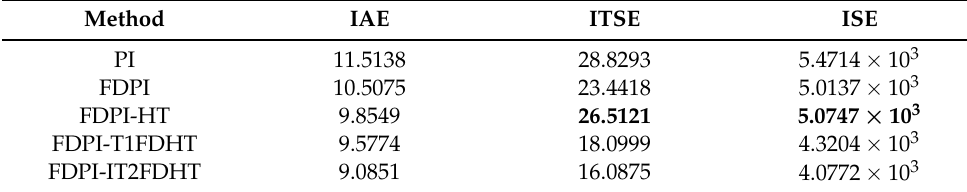
Figure 12. Motor speed tracking results under no-load situation. Table 8. Evaluation indicator results under no-load